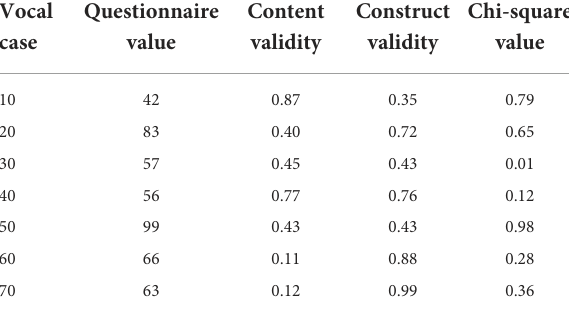
TABLE 1 Vocal expressiveness